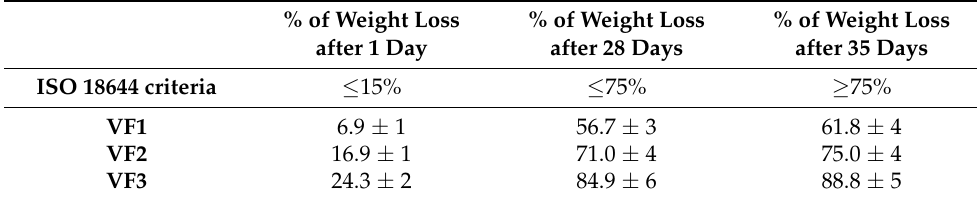
Table 5. % of weight loss after an immersion time of 1, 28 and 35